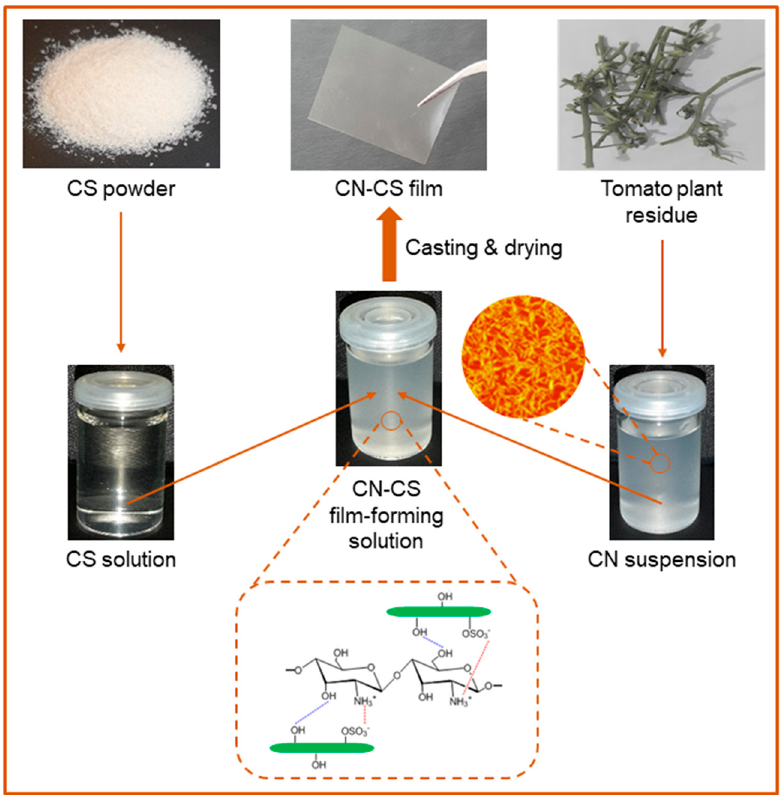
Figure 1. Schematic presentation of the cellulose nanocrystal reinforced chitosan (CN–CS) bio-nanocomposite films preparation.